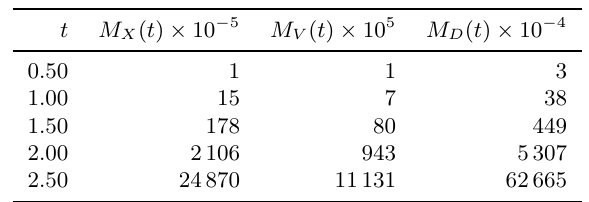
Table 2: M X ( t ) , M V ( t ) and M D ( t ) as a function of t (before treatment) with C = 3 , N = 412 ,